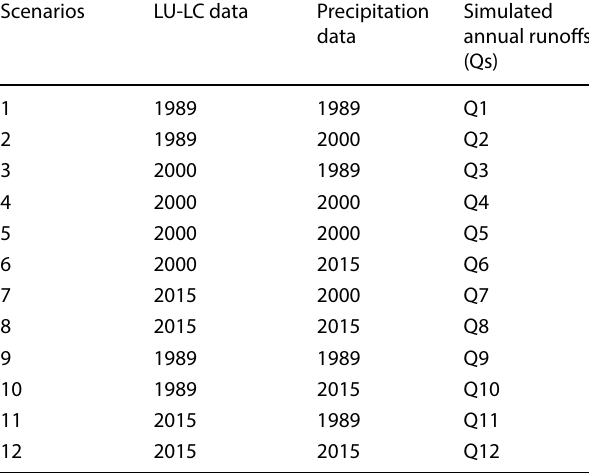
Table 1 Scenarios used for quantitative impact